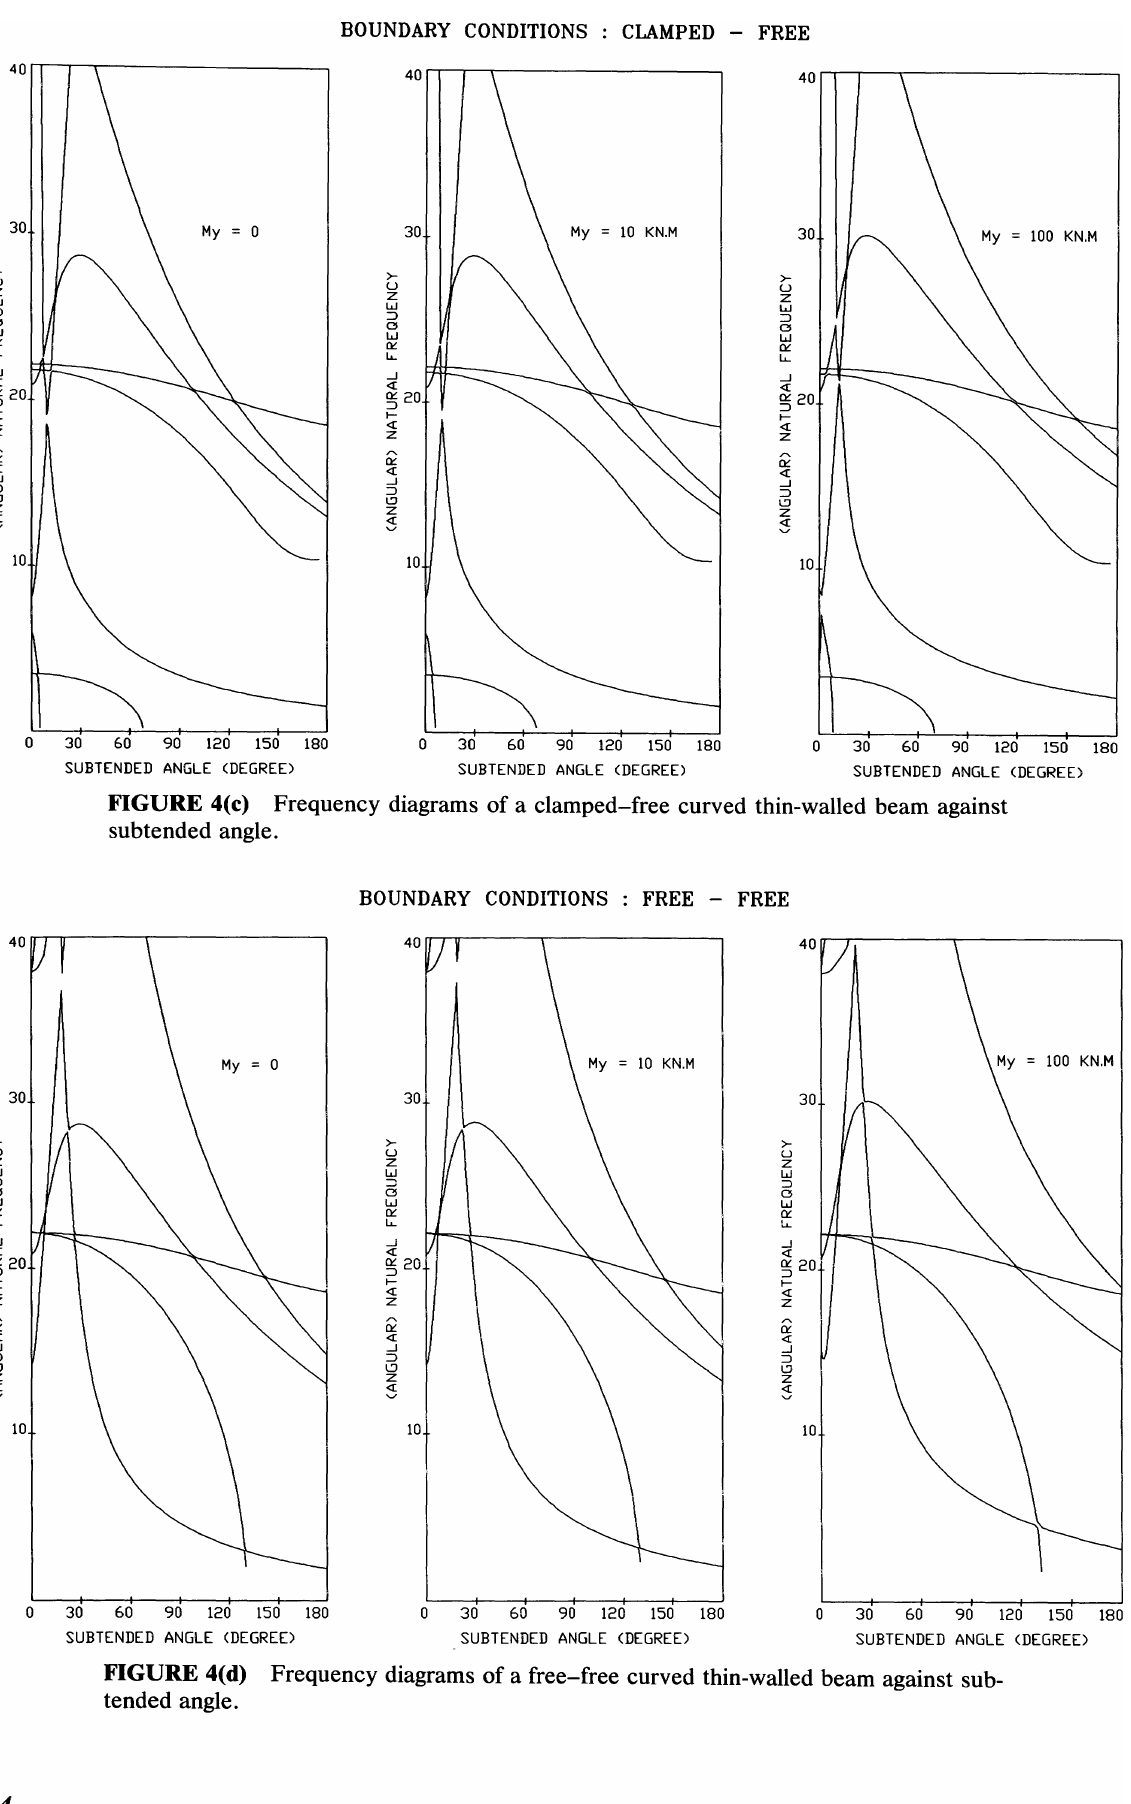
FIGURE 4(d) Frequency diagrams of a free-free curved thin-walled beam against sub tended